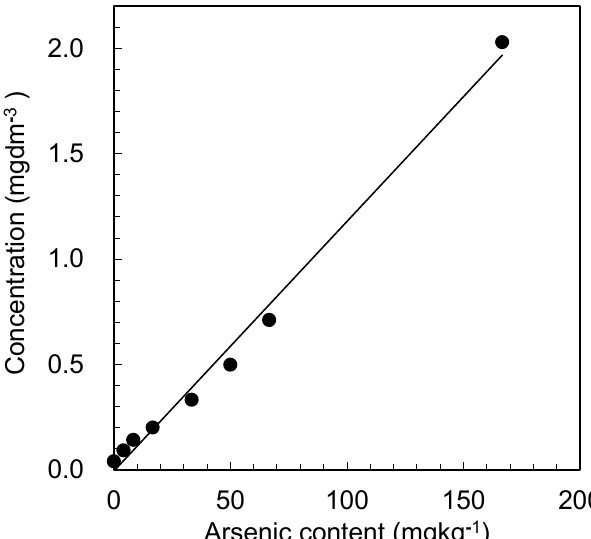
Figure 3. Arsenic concentrations in the water sample, as measured by ICP-AES, after treating the suspensions of the arsenic-containing gypsum samples with a cation-exchange resin as a function of the known arsenic content in the prepared samples. Experimental condition: gypsum: 0.3 g, cation-exchange resin: 4 g in 20 mL of water.